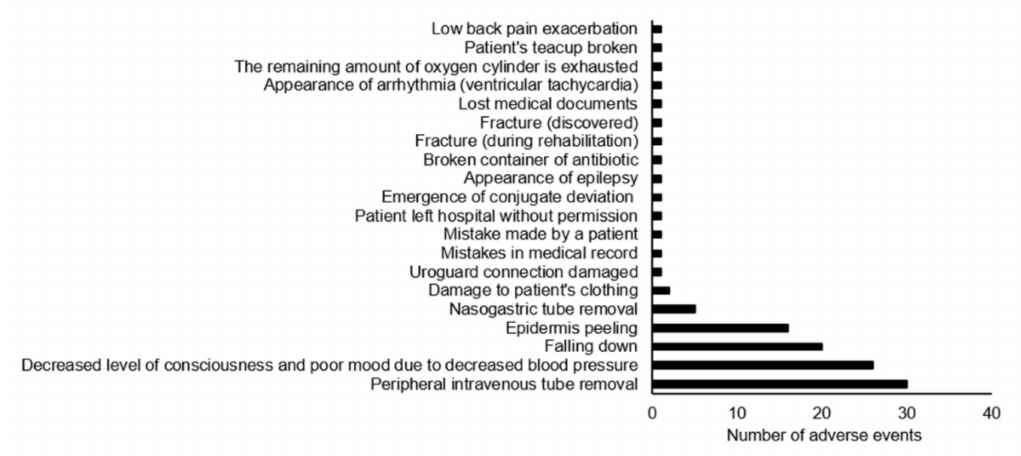
Figure 3. Content of adverse event cases and number of